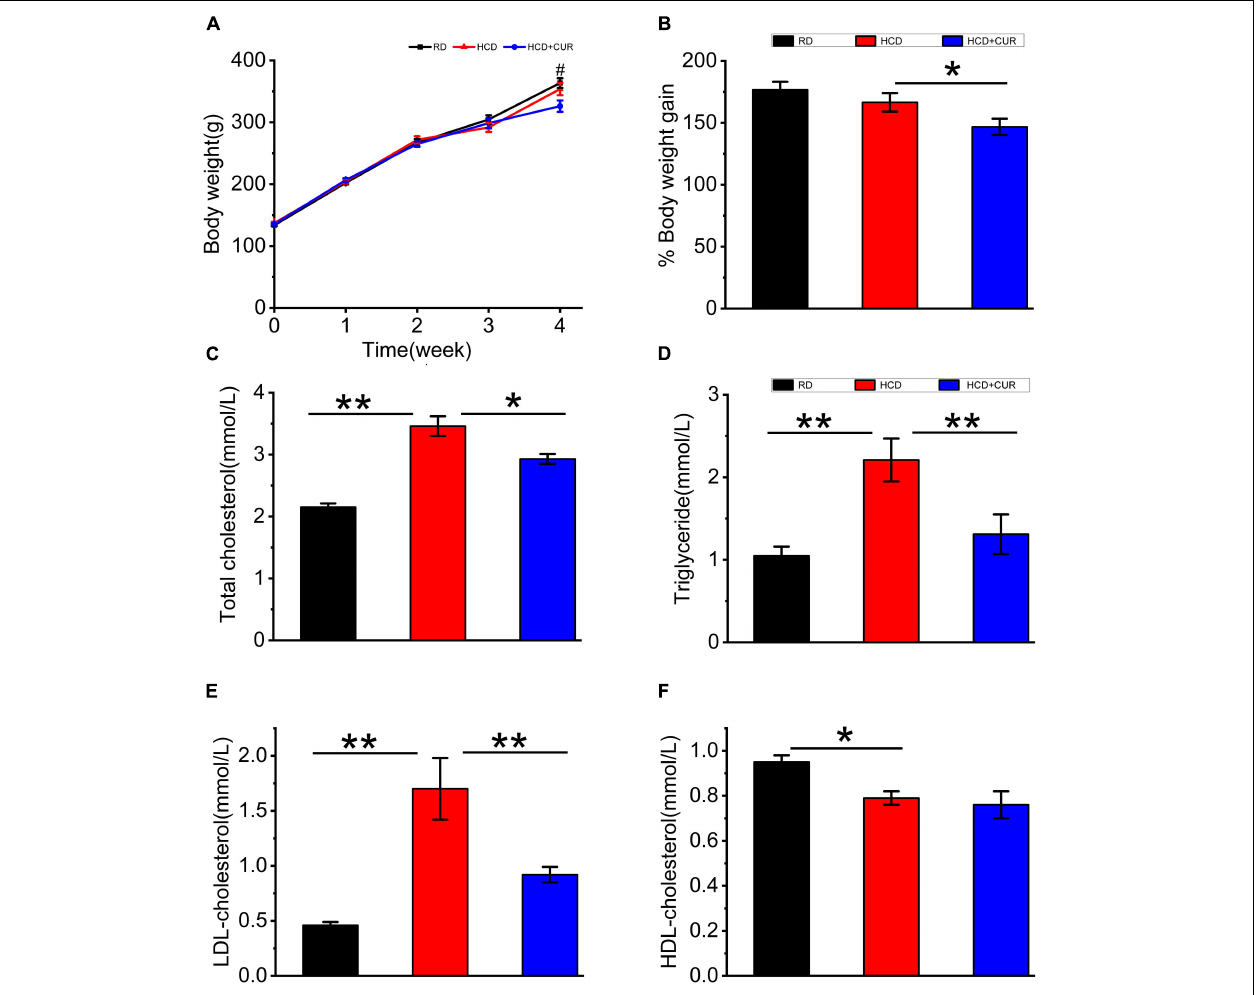
FIGURE 2 | Changes in body weight and plasma lipid profiles in rats. (A) Weekly body weight (g); (B) body weight gain (%); (C) total cholesterol (TC); (D) triglyceride (TG); (E) LDL-cholesterol (LDL-C); (F) HDL-cholesterol (HDL-C). RD, control group; HCD, high cholesterol diet group; HCD + CUR, high cholesterol diet receiving a daily dose of 200 mg/kg body weight curcumin by gavage for 4 weeks. Carotid injury was induced by an air-drying endothelial denudation method at the end of the second week. Data are representative of two independent experiments and expressed as mean ± SE, n = 10 for each group. # P < 0.05, vs. HCD group; * P < 0.05, ** P <